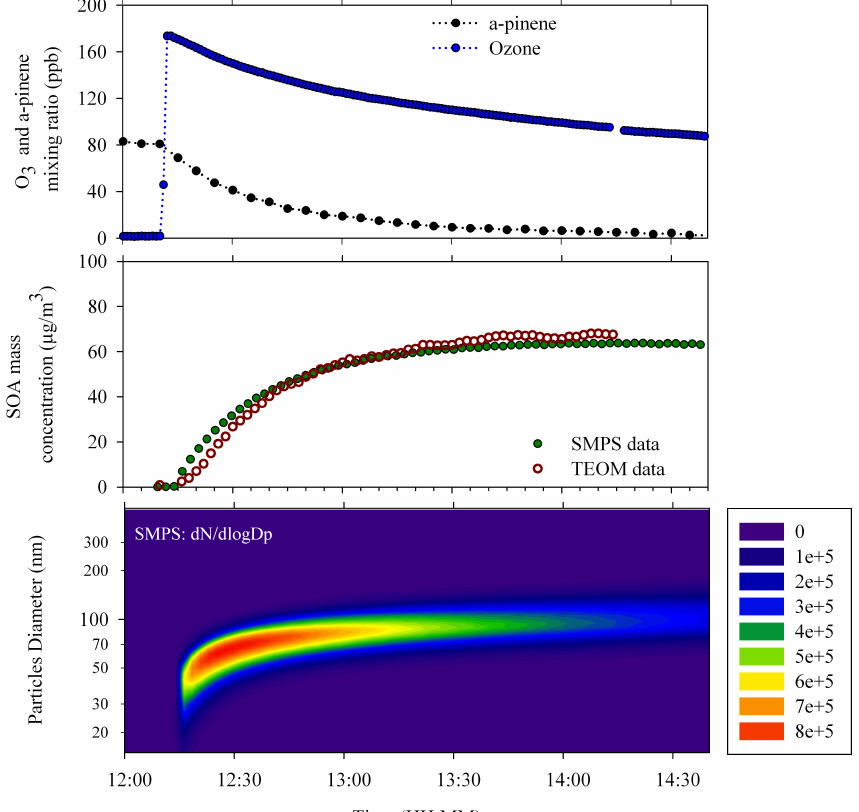
Fig. 11. Time dependent concentrations, aerosol mass and size distribution during an experiment of ozonolysis of α -pinene (experiment #100323-A). Top panel: ozone and α -pinene concentrations from ozone monitor and FTIR measurements; middle panel: aerosol mass concentrations from both SMPS and TEOM measurements; bottom panel: aerosol size distribution in number determined by